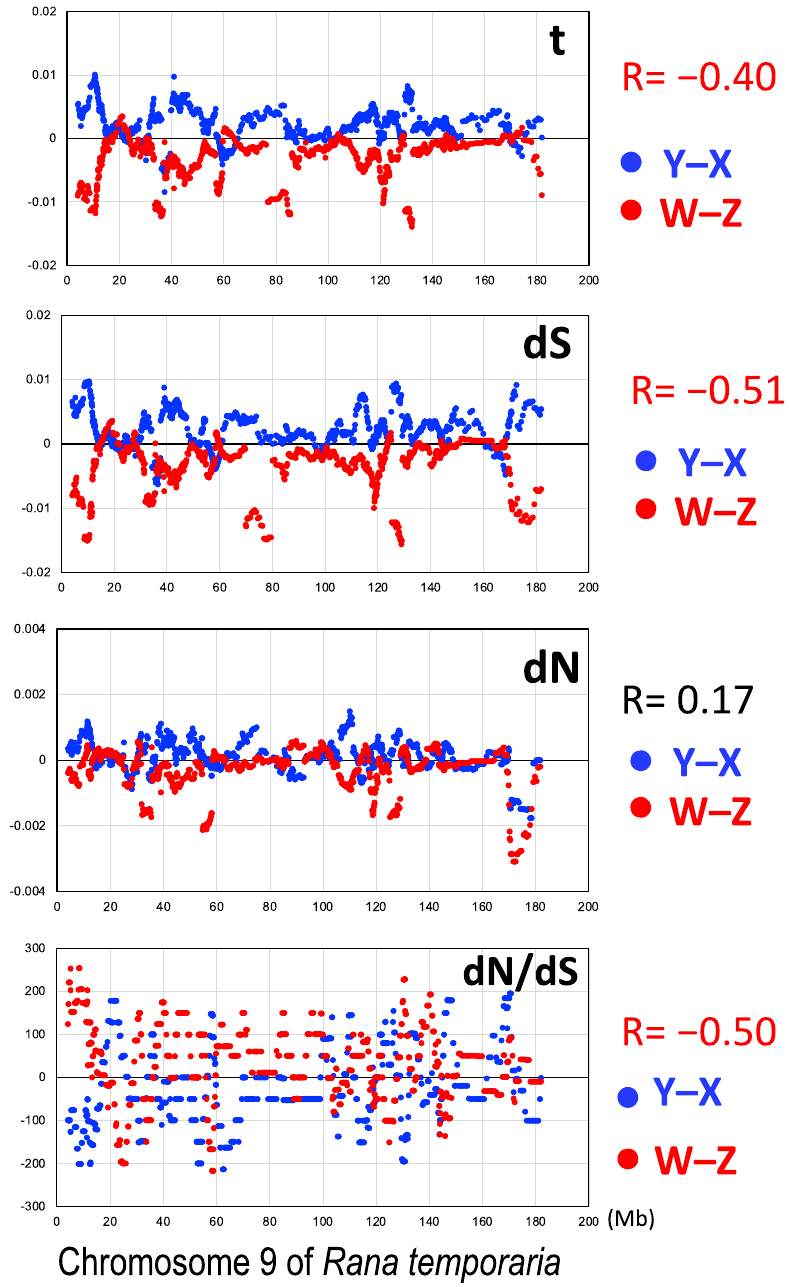
Figure 5. Distribution of the nucleotide substitution rates in the sex-linked genes along the chromo- somal axis. Blue circles indicate the subtracted values of the nucleotide substitutions in X-genes from those in Y-genes for t, dS, dN, and dN/dS, while red circles indicate those in Z-genes from those in W-genes. The abbreviations are the same as in Figures 2 and 4.